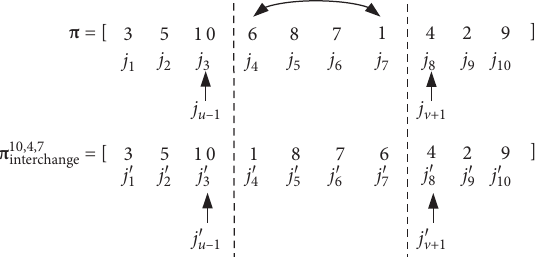
when n � 10, u � 4, and